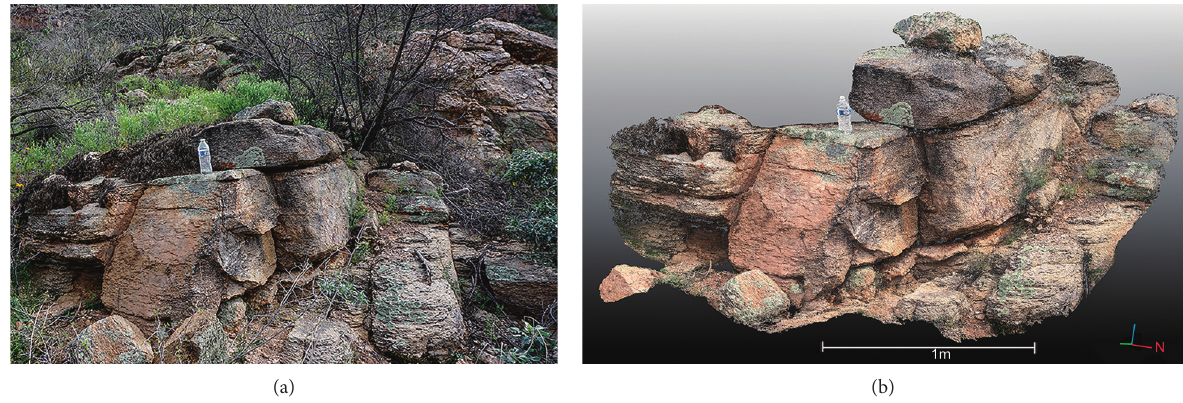
Figure 8: Point clouds of rock block sample generation by photogrammetry. (a) Rock block samples that were taken at the bottom of the Thimble peak. (b) Point cloud data of the rock block samples generated in Pix4D and segmented in CloudCompare